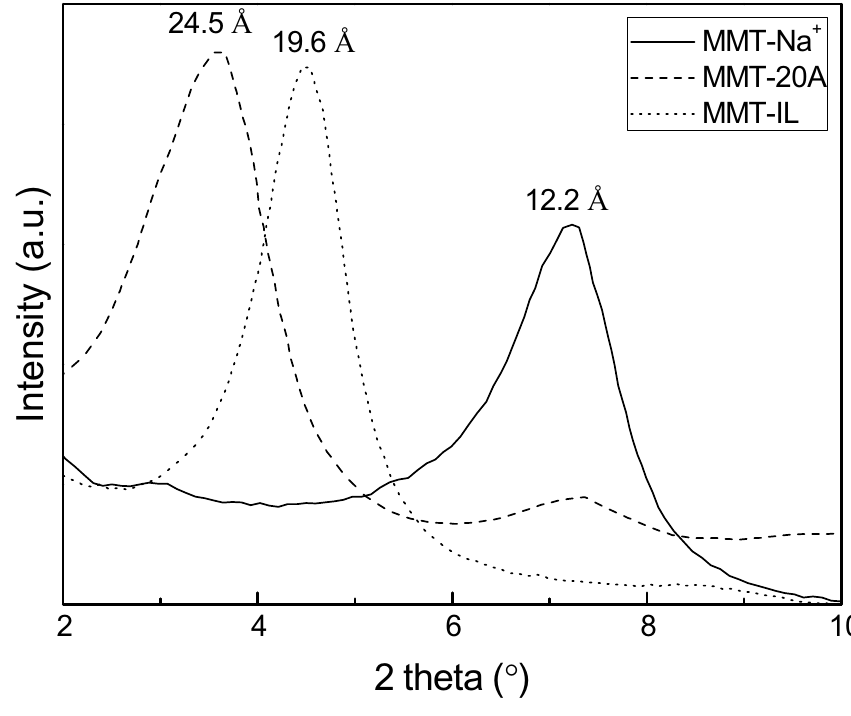
Fig. 2 WAXS patterns of pris- tine MMT-Na + and organically modified MMT